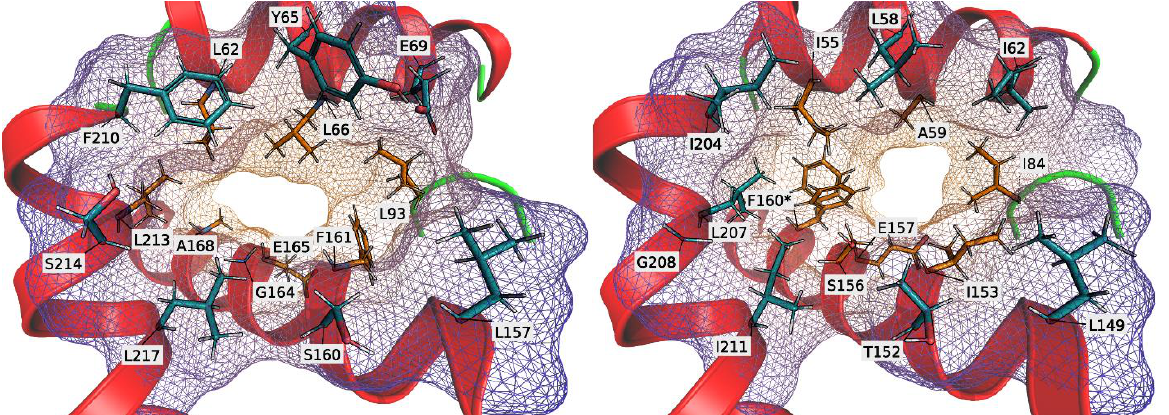
Figure 8. Amino acids defining the substrate access channel of r Ani UPO (left) and Mro UPO (right) in a top-down view from the protein surface to the channel bottleneck. Main-chain secondary structures are shown as cartoon helices (red) or loops (green). Side-chains (depicted as sticks) are labeled using the IUPAC standard one-letter amino acid code. The field-of-view was reduced to 60° (aids depth-perception and reduces visual cluttering). The solvent excluded surface (SES) of the channel-lining amino acids is depicted as a colored mesh (ignoring all other amino acids). The meshes are colored from blue (bottleneck distal) to orange (bottleneck proximal) and are colored in approximation as the amino-acid side-chains that either form the channel-bottleneck (in orange) or rather the outer channel perimeter (in blue). (*) F160 in the resolved structure for Mro UPO (5FUK) has two rotamer-solutions (while 5FUJ has two rotamer-solutions for I55 but not F160; not